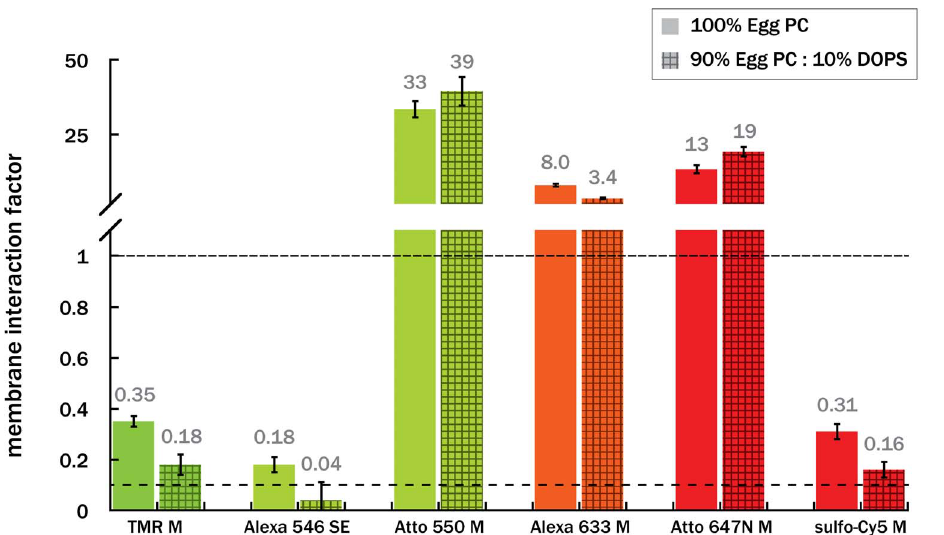
Figure 4. MIF corr_neg values for a subset of dyes interacting with negatively charged 9:1 Egg PC:DOPS vesicles. For comparison, the corrected MIF values of the dyes with pure Egg PC (MIF corr , solid bars) are shown to the left of the MIF values with DOPS (MIF corr_neg, hashed bars). The MIF values in both lipid compositions, calculated as described in Equation 3, are displayed above each bar, and are given in Table 2. Dyes below the bottom dashed line (MIF , 0.1) exhibit little to no association with Egg PC lipid bilayers, while dyes above the second dashed line (MIF . 1) strongly associate with membranes. Note that the y-axis changes substantially at MIF . 1.1. Each data point represents the average of three independent measurements, 6 propagated error of the standard deviation. The difference between MIF corr_neg and MIF corr for all dyes shown is statistically significant at the p , 0.05 level, as determined by a two-sample Kolmogrov-Smirnov test.